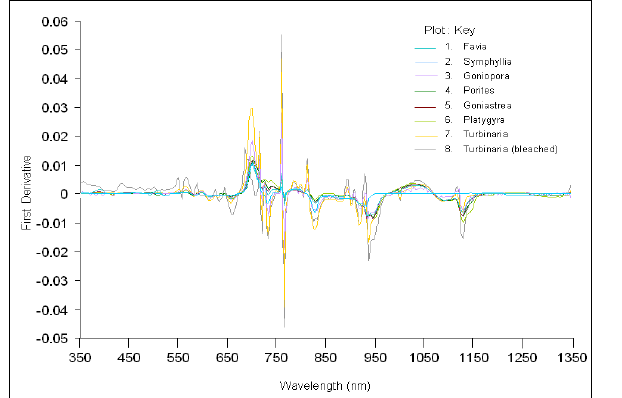
Figure 6. First derivatives of the sampled coral spectra